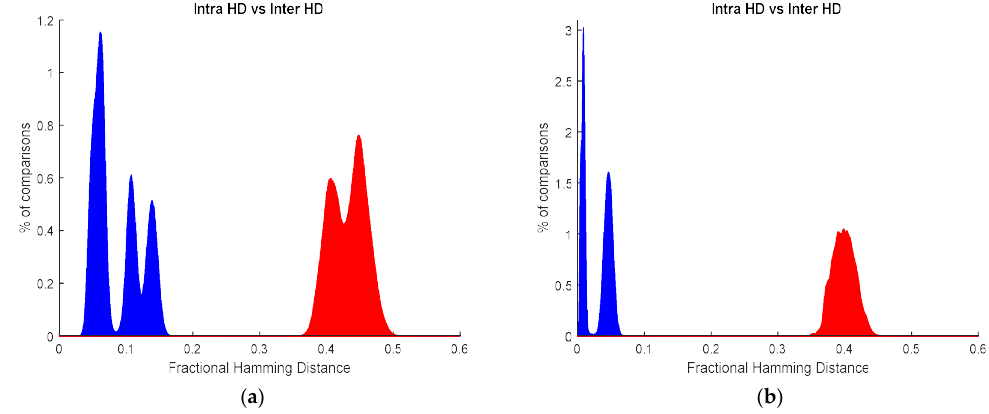
Figure 3. Fractional hamming distances obtained from the PUF responses ( a ) considering all SRAM cells and ( b ) considering only STB